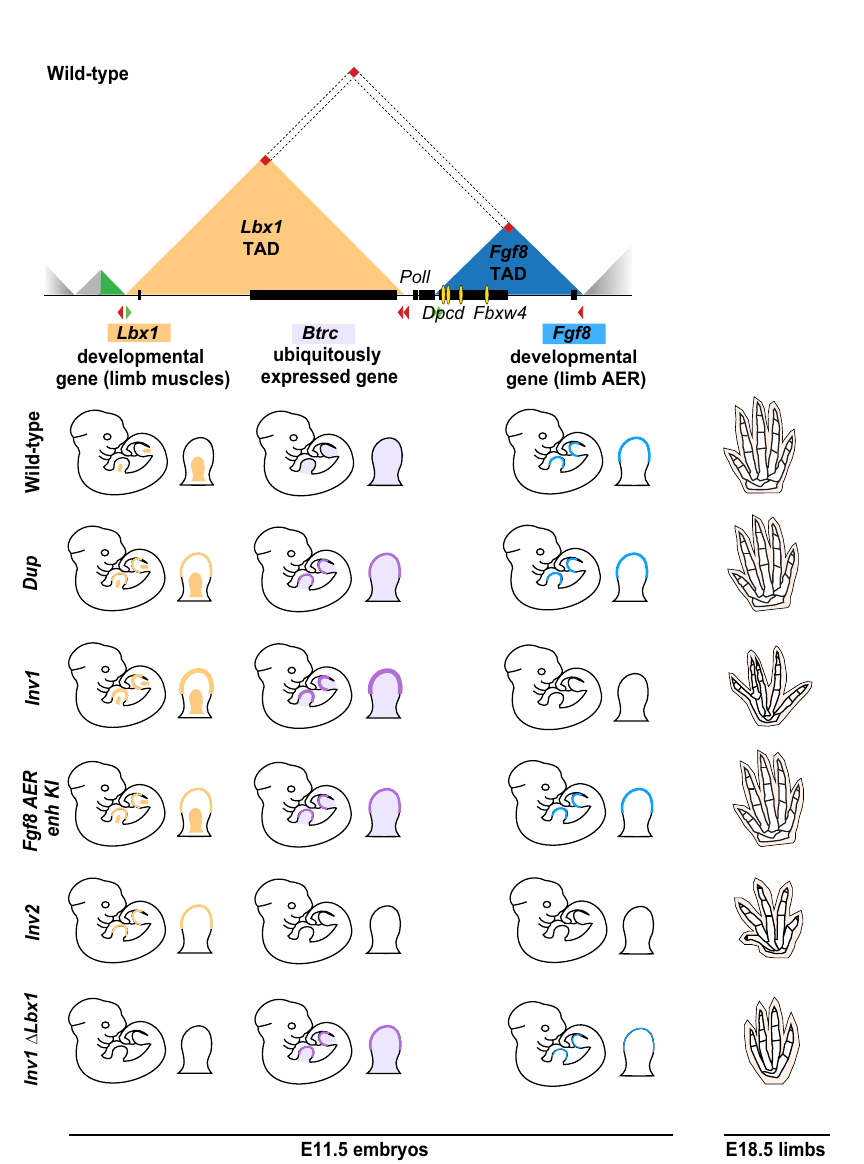
Fig.7|Combinatorialeffectsongeneexpressionatthe Lbx1 / Fgf8 locusleadsto SHFM3 digit fusion phenotype. Schematic overview of the Lbx1-Fgf8 TADs (top) and Lbx1 , Btrc and Fgf8 expression in the developing limb at E11.5 and skeletal phenotype at E18.5 among the different structural rearrangements (bottom). Yel- low and violet patterns represent endogenous expression in the limb bud and misexpression in the AER of Lbx1 and Btrc , respectively. Turquoise pattern high- lights Fgf8 expression in the AER. Ectopic expression of both Lbx1 and Btrc in the AERisobservedforthe Dup , Inv1 and Fgf8 AERenhancerKI( Fgf8AERenhKI )mutant